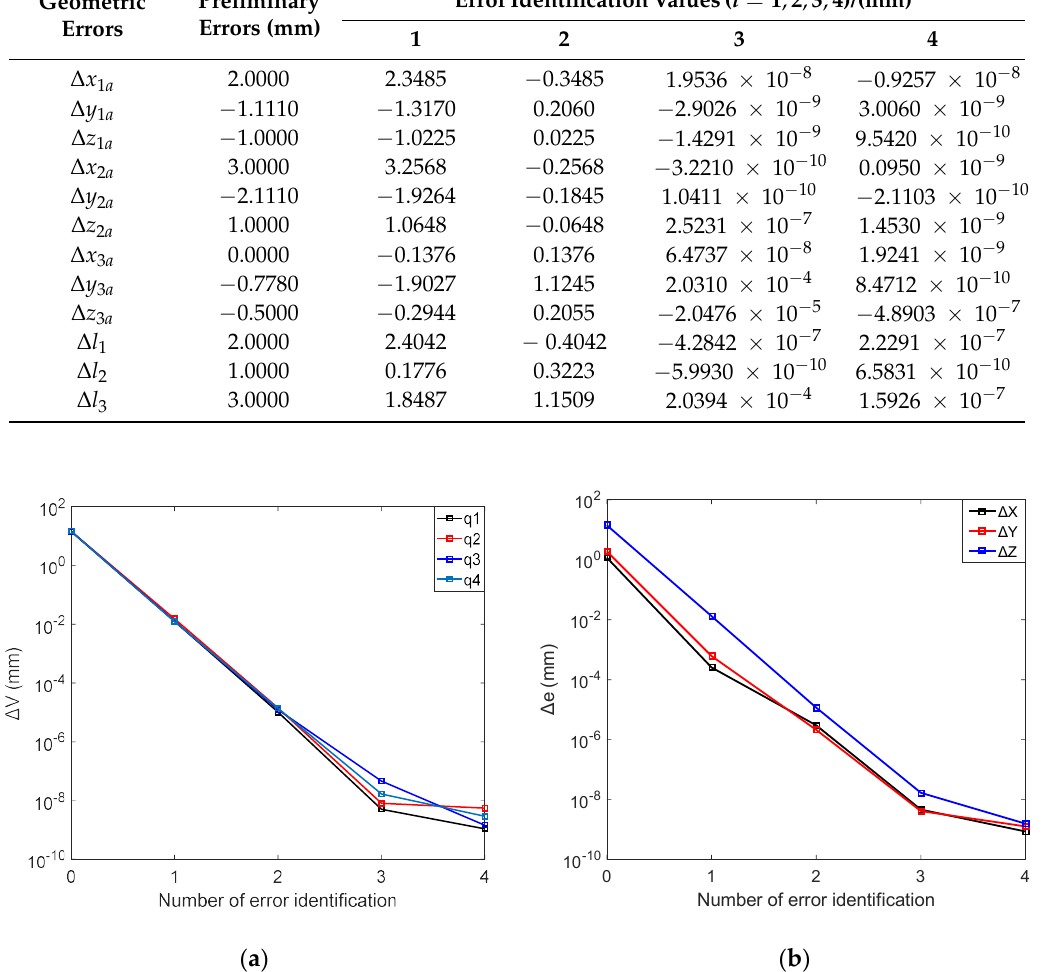
Figure 8. The relationships between errors and identification times: ( a ) The change of construction volume errors; ( b ) The change of position errors.